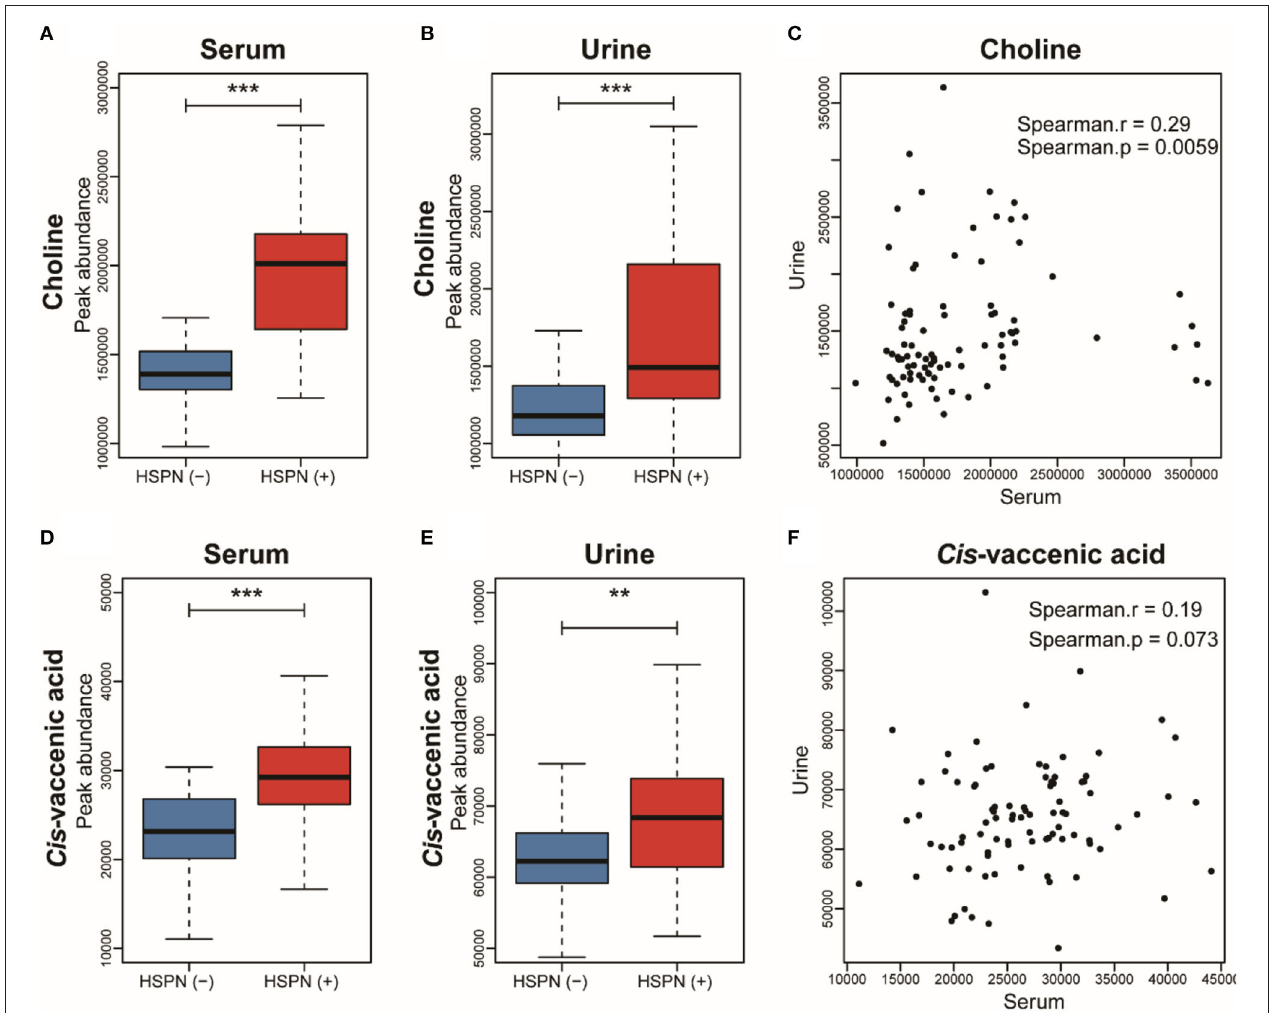
FIGURE 3 | Boxplot analysis of choline in (A) serum and (B) urine between HSPN (–) and HSPN ( + ) patients. (C) Spearman correlation analysis of the levels of choline in serum and urine. Boxplot analysis of cis -vaccenic acid in (D) serum and (E) urine between HSPN (–) and HSPN ( + ) patients. (F) Spearman correlation analysis of the levels of cis -vaccenic acid in serum and urine. ** p < 0.01 and *** p <